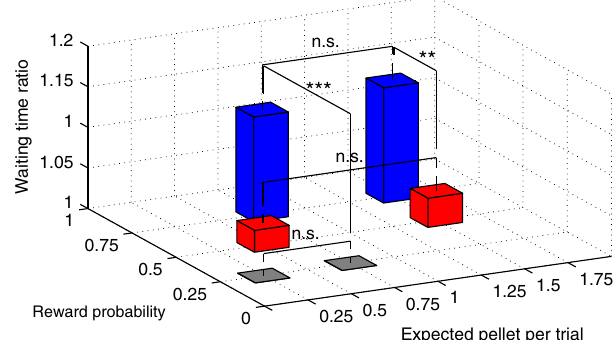
Fig. 4 The role of serotonin in promoting patience is modulated by reward probability, but not by reward value. Waiting time ratios: 75% one-pellet test (1.13 ± 0.01, n = 57 tests from 6 mice), 75% two-pellet test (1.14 ± 0.02, n = 30 tests from 5 mice), 25% one-pellet test (1.00 ± 0.01, n = 38 tests from 6 mice), 25% three-pellet test (1.00 ± 0.01, n = 41 tests from 6 mice), 50% one-pellet test (1.03 ± 0.01, n = 21 tests from 3 mice), and 50% three-pellet test (1.04 ± 0.02, n = 19 tests from 3 mice). Waiting time ratios were signi fi cantly larger in 75% reward tests compared with tests having the same expected reward value. ** P < 0.01, *** P < 0.001 by post hoc Bonferroni correction. n.s. not signi fi cant. Error bars represent the